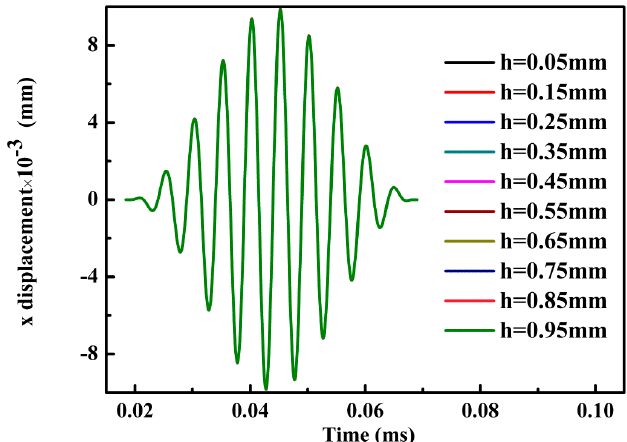
Figure 7. Displacement in x -axis direction at different locations through-thickness direction with the same x coordinate (=100 mm).